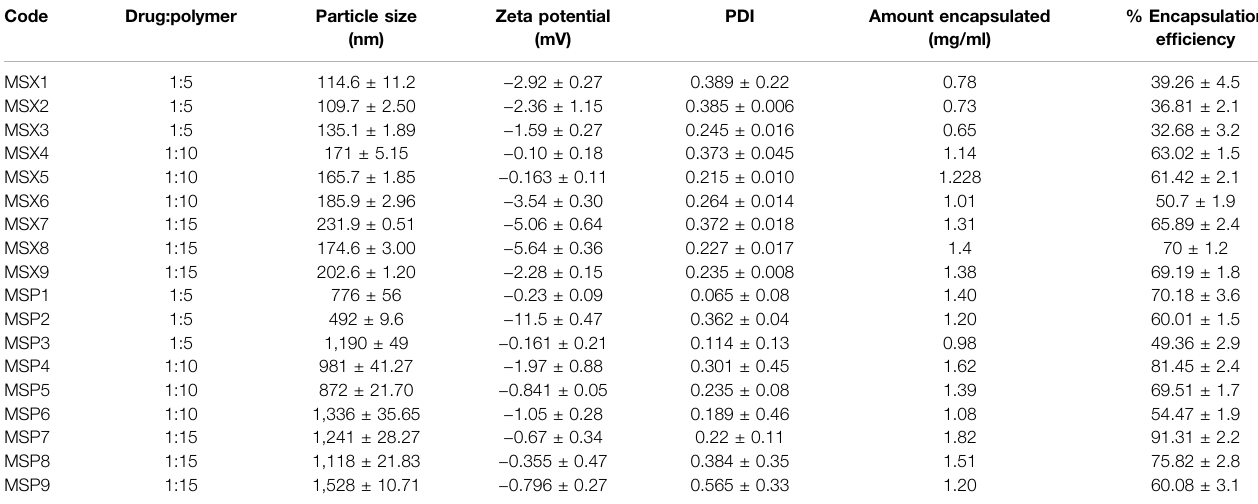
TABLE 5 | Characterization of methotrexate nanoparticles using Eudragit S100.